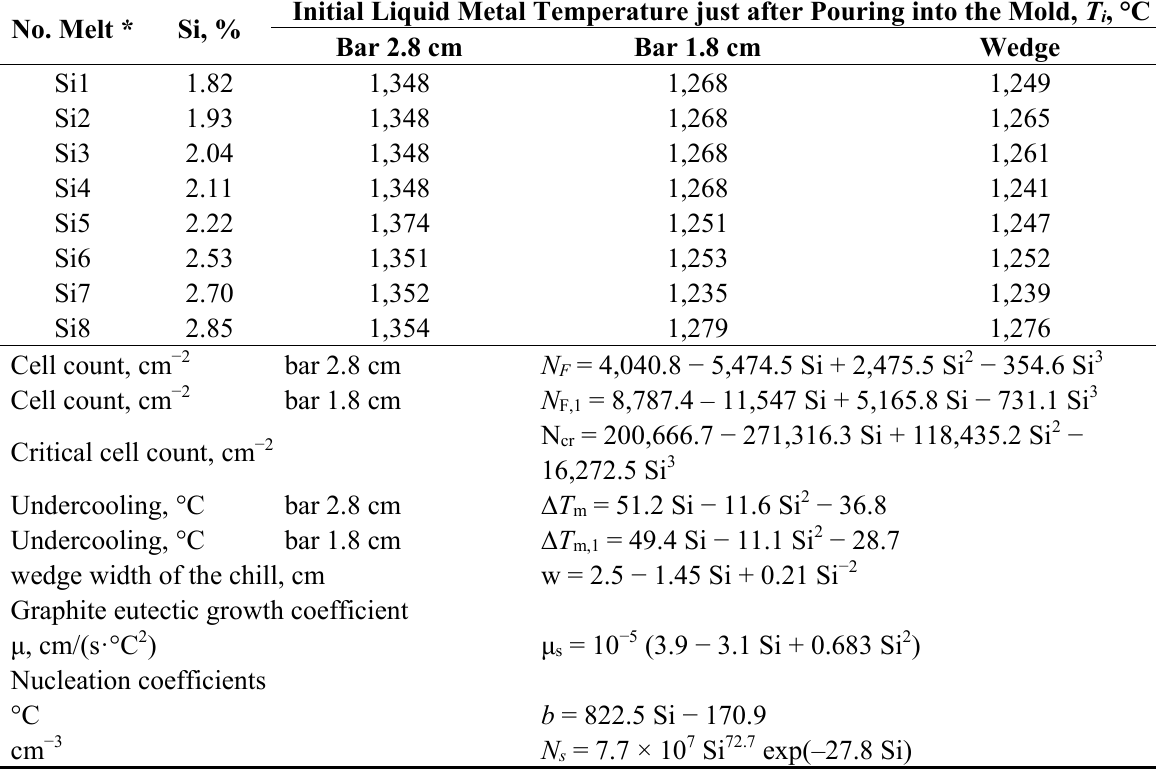
Table 5. Effect of silicon on the resultant T i